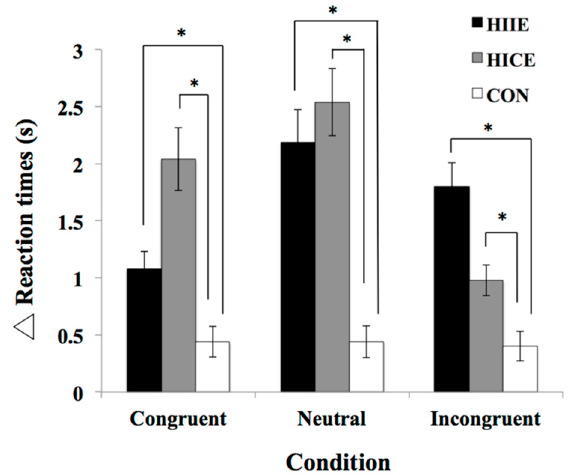
Figure 1. Mean and SE (standard error) of the Δ (difference between pre-test and post-test) reaction time in the Stroop task among the three groups. The High-intensity interval exercise (HIIE) group and the High-intensity continuous exercise (HICE) group showed larger Δ reaction time than the Control (CON) group in three stimulus conditions (Congruent, Neutral and Incongruent condition), whereas no significant difference was observed between the HIIE group and the HICE group. Note: * p < 0.001.